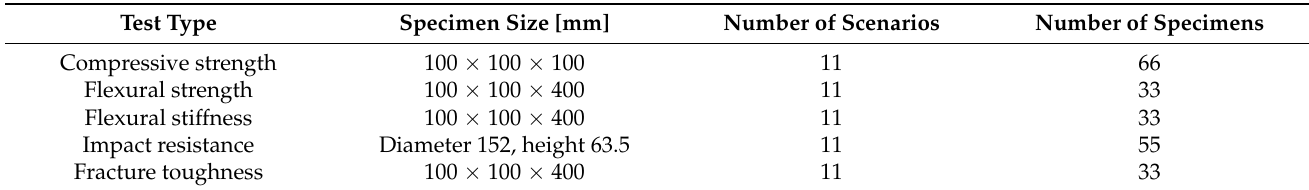
Table 4. Specific size and number of the